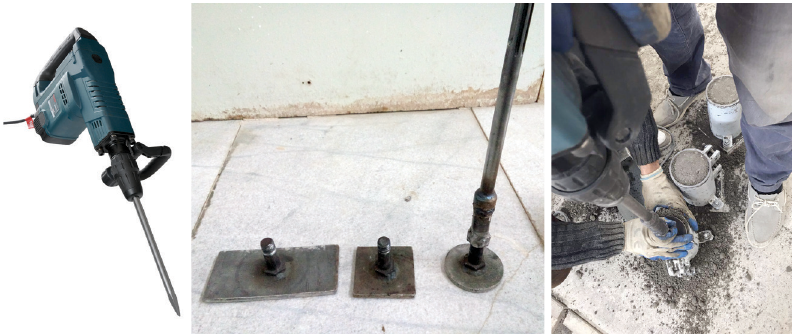
Figure 6. Vibrating hammer (right), plates (middle), and specimen compaction method